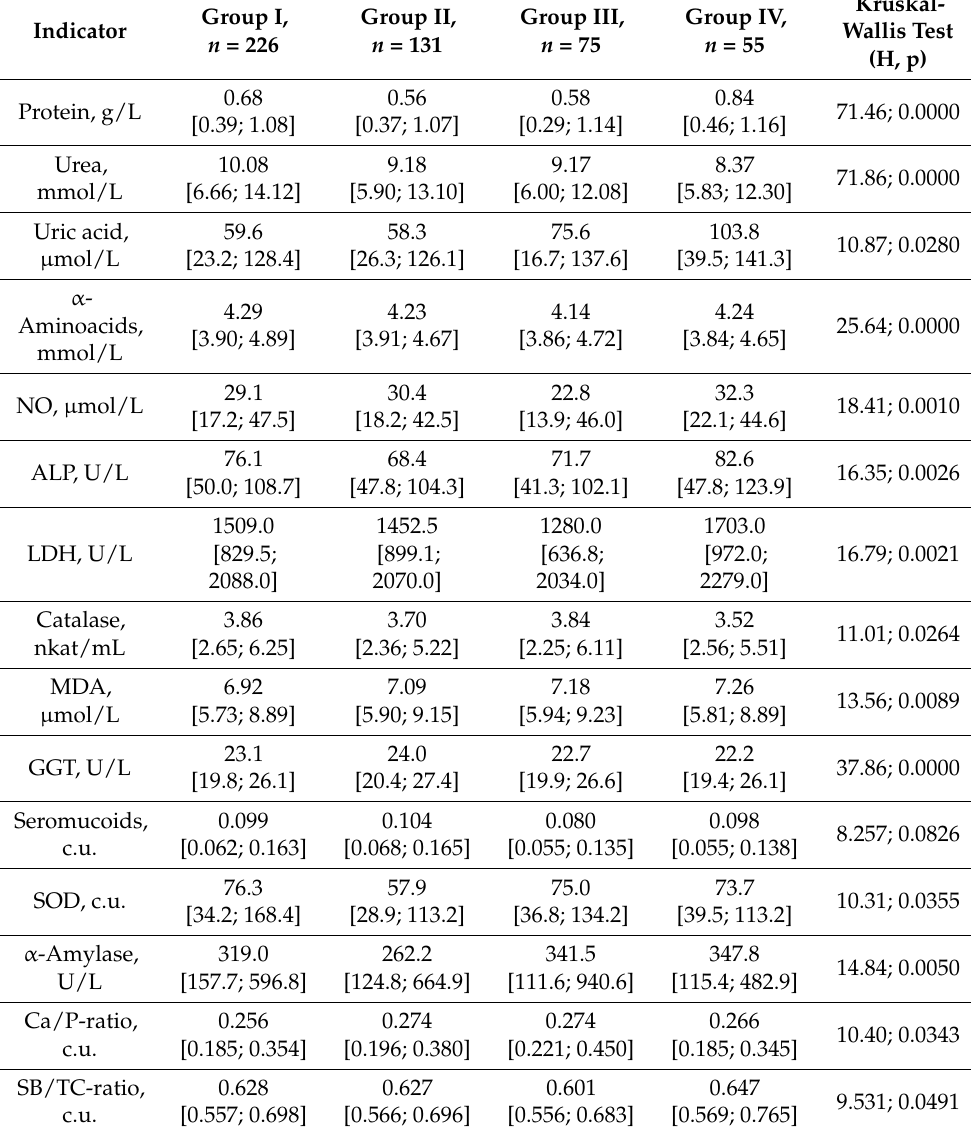
Table 2. Biochemical composition of saliva of patients with breast cancer depending on the